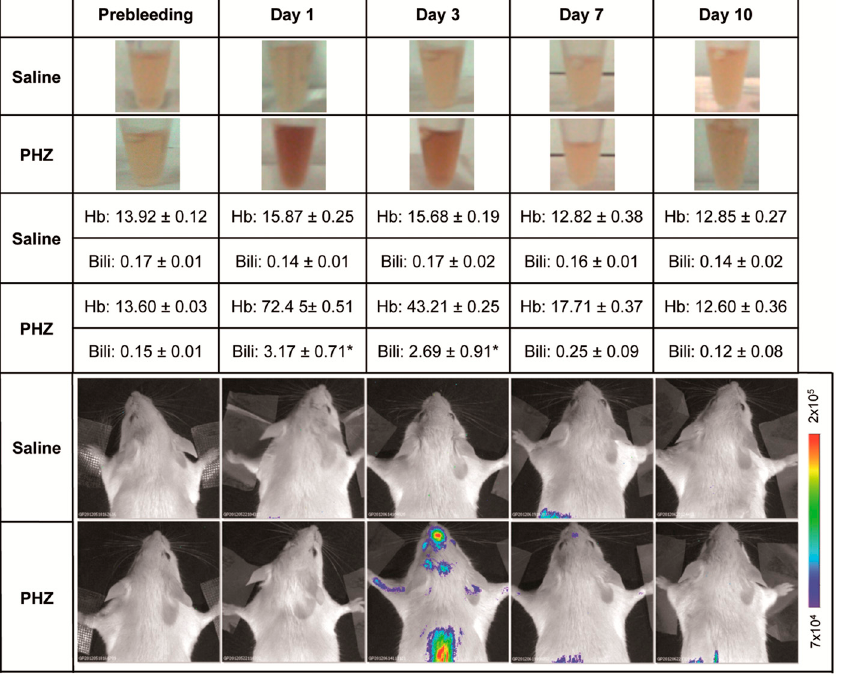
Figure 1. Effect of phenylhydrazine administration into MITO-Luc mice. Saline solution (saline) as control or phenylhydrazine (PHZ) (75 mg/kg) was administered via intra peritoneal route to MITO-Luc mice ( n = 5 per group) to induce experimental hemolysis. At different time points, we collected blood samples by retro-orbital bleeding. The figure shows photographs of about 20 µ L of serum from a representative animal from each group (top rows) and serum levels of hemoglobin (Hb, expressed in g/dL) and total bilirubin (Bili, expressed in mg/dL) (middle rows). Blood samples collected from the animals 3 days before treatment (referred as “prebleeding” in figure) were used as physiological baseline control. Data are mean ± SEM. Normal clinical chemistry values are: total bilirubin 0.1–0.7 mg/dL; hemoglobin 12–16 g/dL. Due to the fact that hemolysis interferes with accurate bilirubin determination, values indicated with an asterisk (*) should be considered approximated values. The bottom part of the figure shows the in vivo bioluminescence imaging of a representative animal for each group performed at the same time points. The color bar and numbers next to the image illustrate the relative bioluminescent signal intensities from the lowest (blue) to the highest (red), with minimal and maximal values expressed in photons per second per square centimeter per steradian (photons/s/cm 2 /sr).